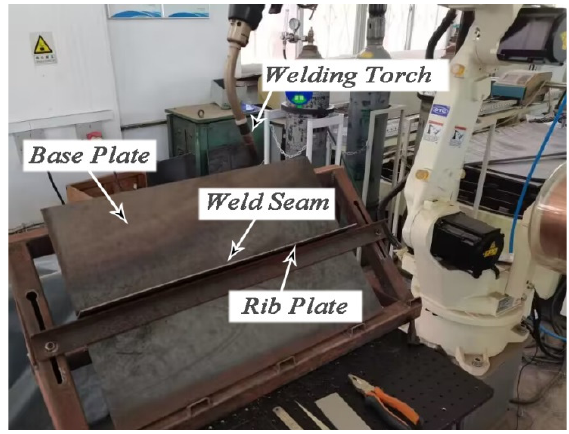
Figure 1. Schematic diagram of welding